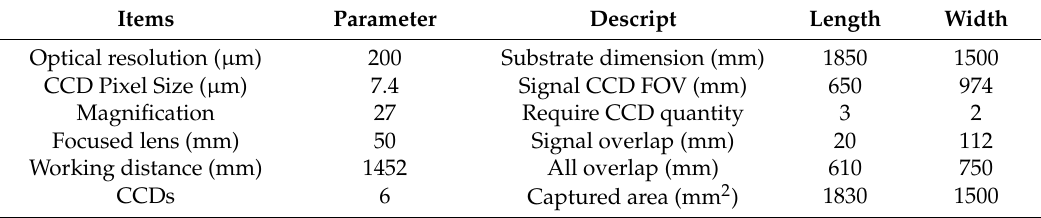
Figure 3. Schematic diagram of side-view illustration for protrusive detection system. Table 1. Specifications of optical design for protrusive detection at 6th glass of TFT.